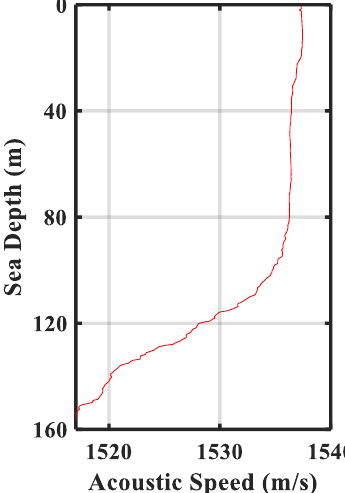
Figure 10. Measured sound velocity.